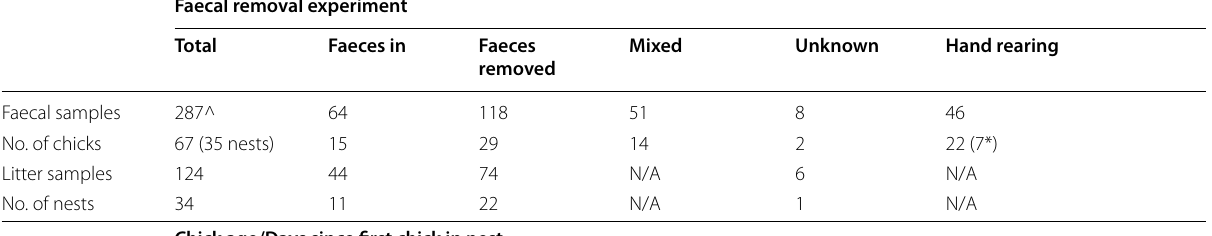
Table 1 Distribution of faecal (chicks) and litter (nest) samples with covariate